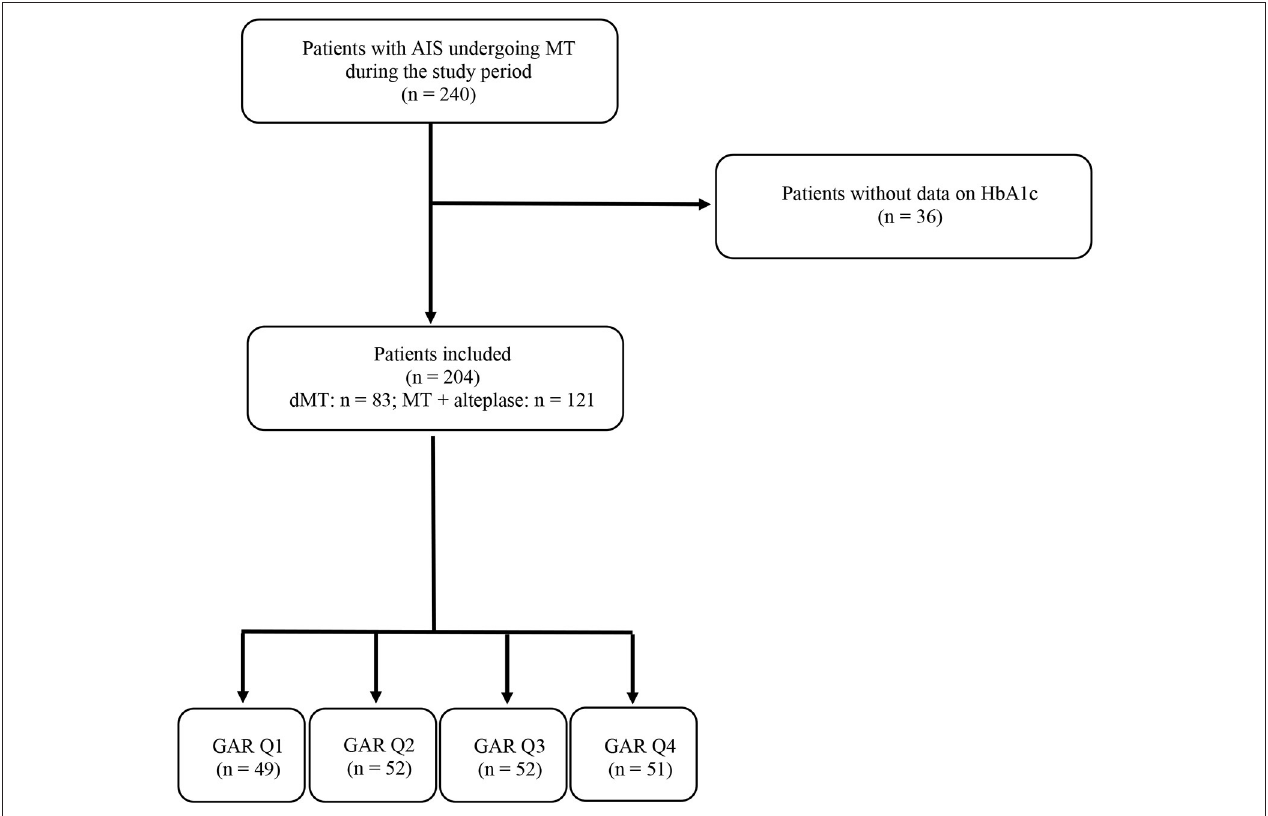
FIGURE 1 | Flow diagram of the study. AIS, acute ischemic stroke; MT, mechanical thrombectomy; HbA1c, glycated hemoglobin; dMT, direct mechanical thrombectomy; GAR Q1, first glucose-to-glycated hemoglobin ratio quartile; GAR Q2, second glucose-to-glycated hemoglobin ratio quartile; GAR Q3, third glucose-to-glycated hemoglobin ratio quartile; GAR Q4, fourth glucose-to-glycated hemoglobin ratio quartile.